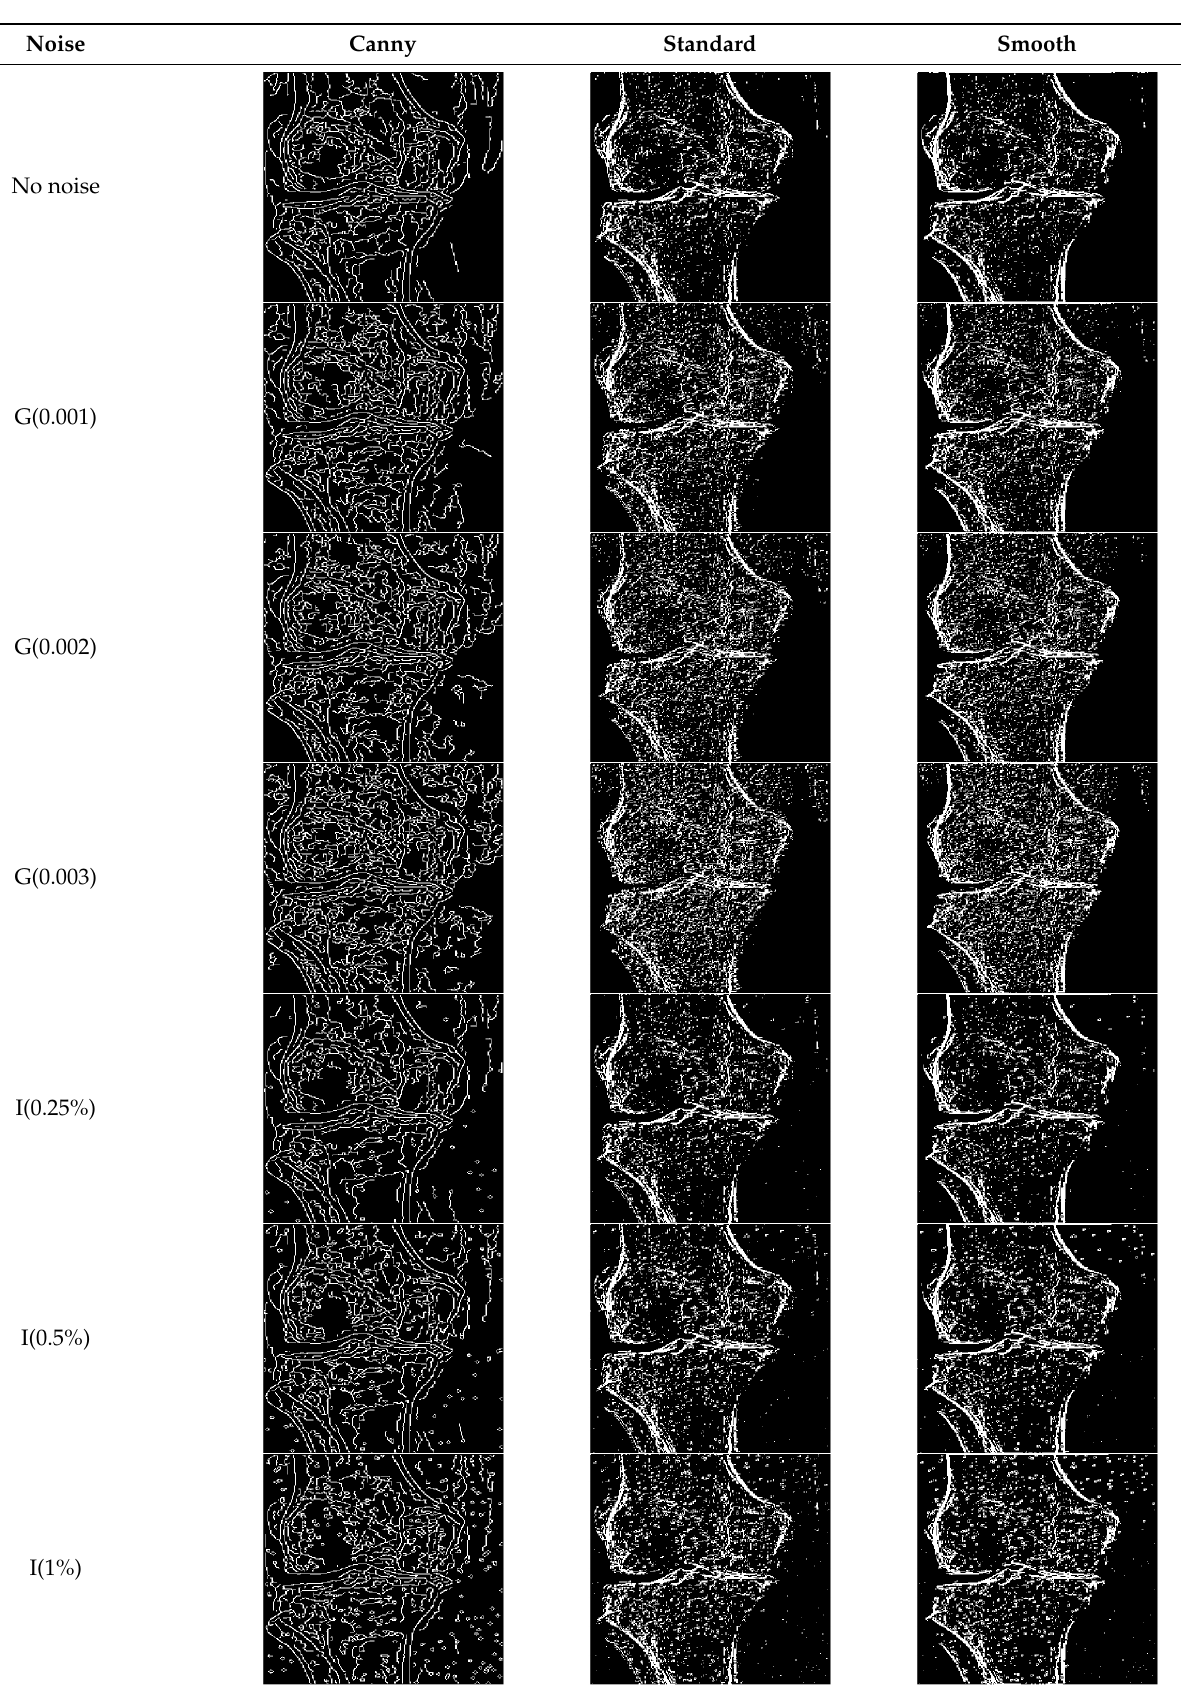
Table 13. Edge-detected image of “X-ray 4” after binarization for different